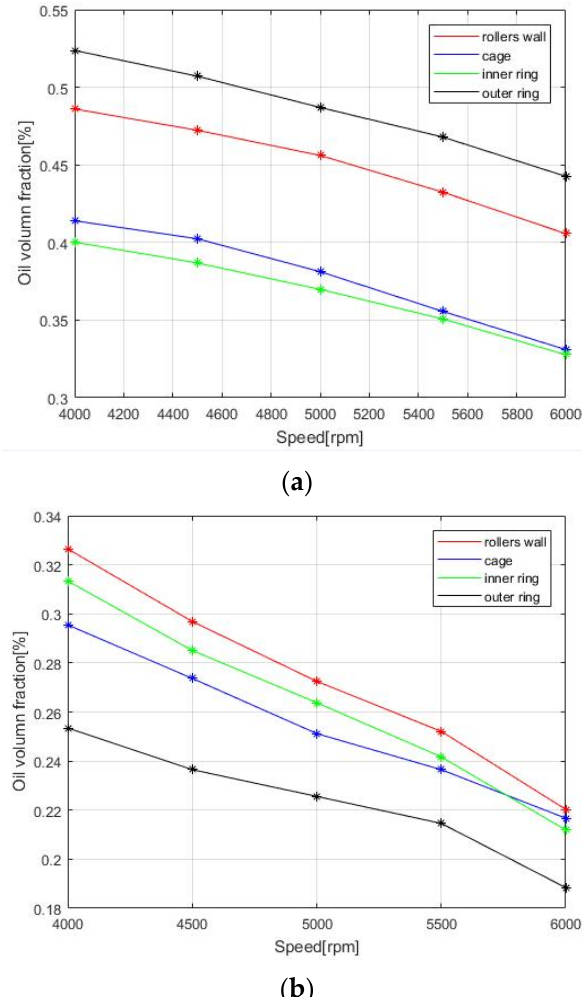
Figure 19. Lubricating oil distributions on various bearing components at different rotational speeds. ( a ) Outer ring rib structure; ( b ) Inner ring rib structure. Table 7. Relationships obtained by numerical